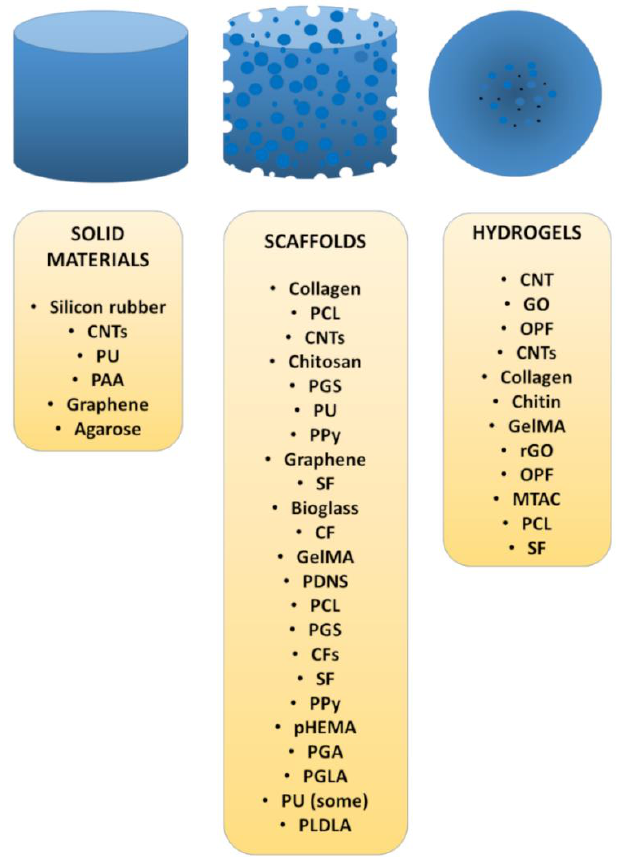
Figure 3. Different physical forms and chemical compositions of biomaterials for the regeneration of the nervous system.